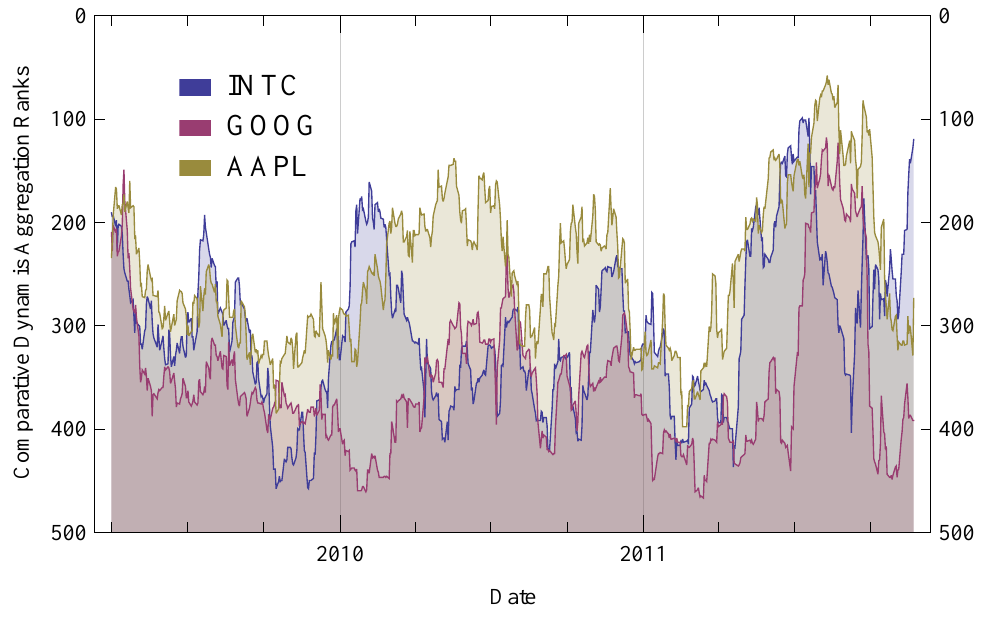
Figure 12. Dynamis aggregation rank of our three stocks over the time period considered.